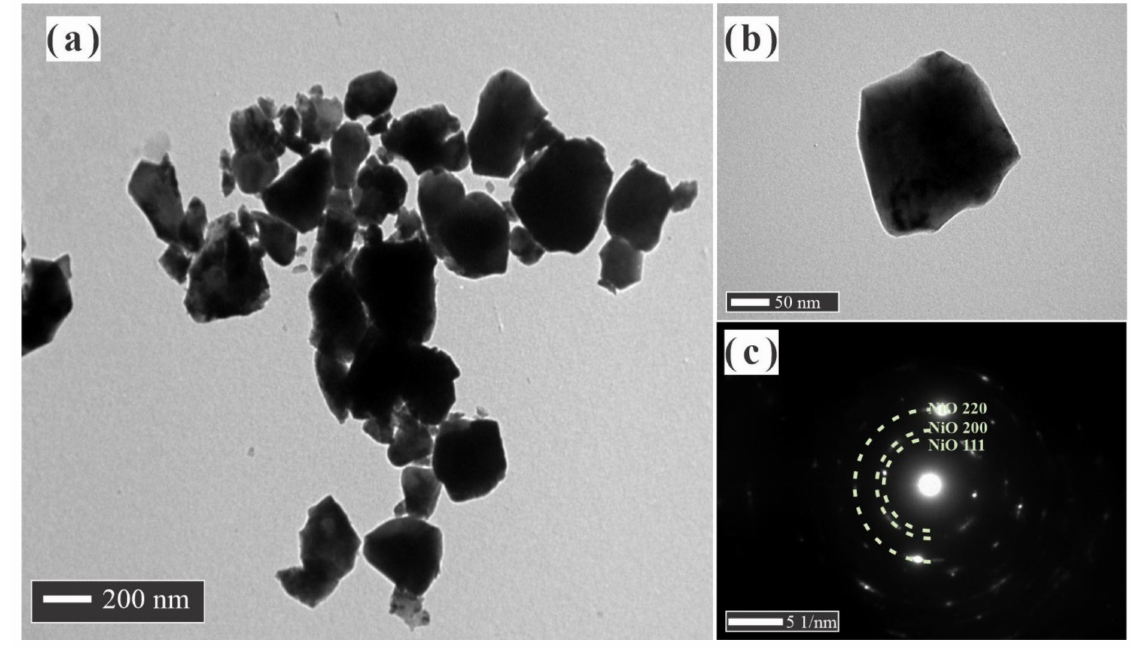
Figure 2. ( a , b ) TEM images and ( c ) SAED pattern of NiO